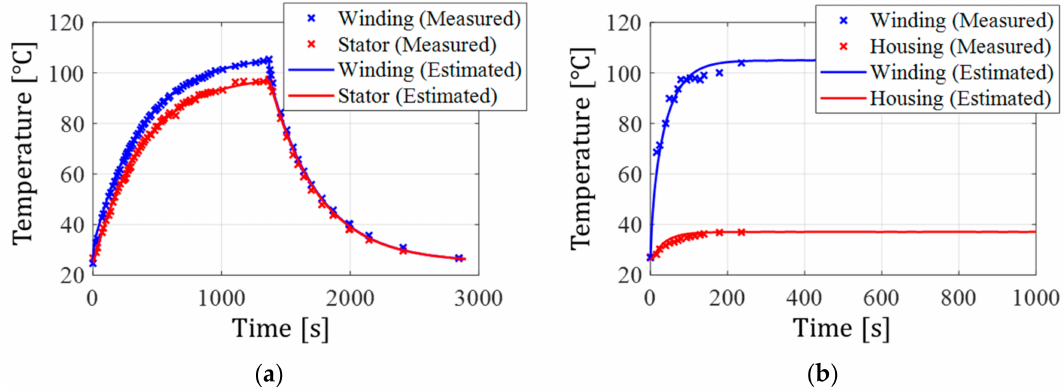
Figure 8. ( a ) Thermal responses of the motor without housing; ( b ) Thermal responses of the motor with housing in the forced air-cooling condition.